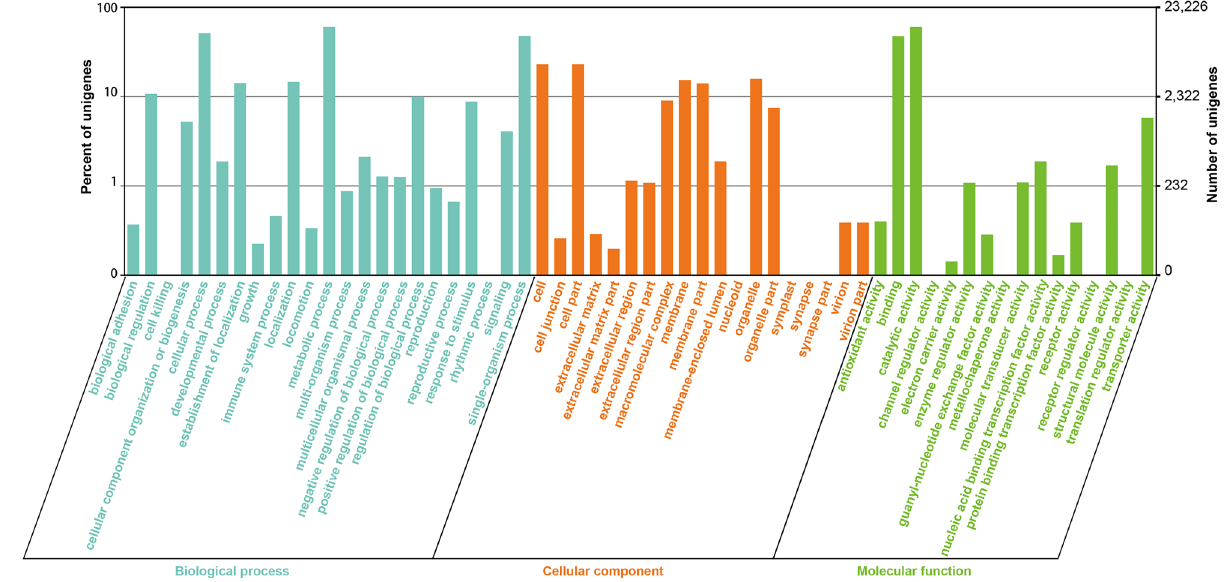
Figure 3. Gene Ontology (GO) classification of S. latifolia . The histogram of GO annotations was generated by in-house Perl and R scripts. The unigenes were classified into three main GO categories: ‘Cellular component’, ‘Molecular function’, and ‘Biological process’. On the right Y-axis is the number of unigenes in each category, while on the left Y-axis is the percentage of a specific category. Each unigene could be assigned with more than one GO term.